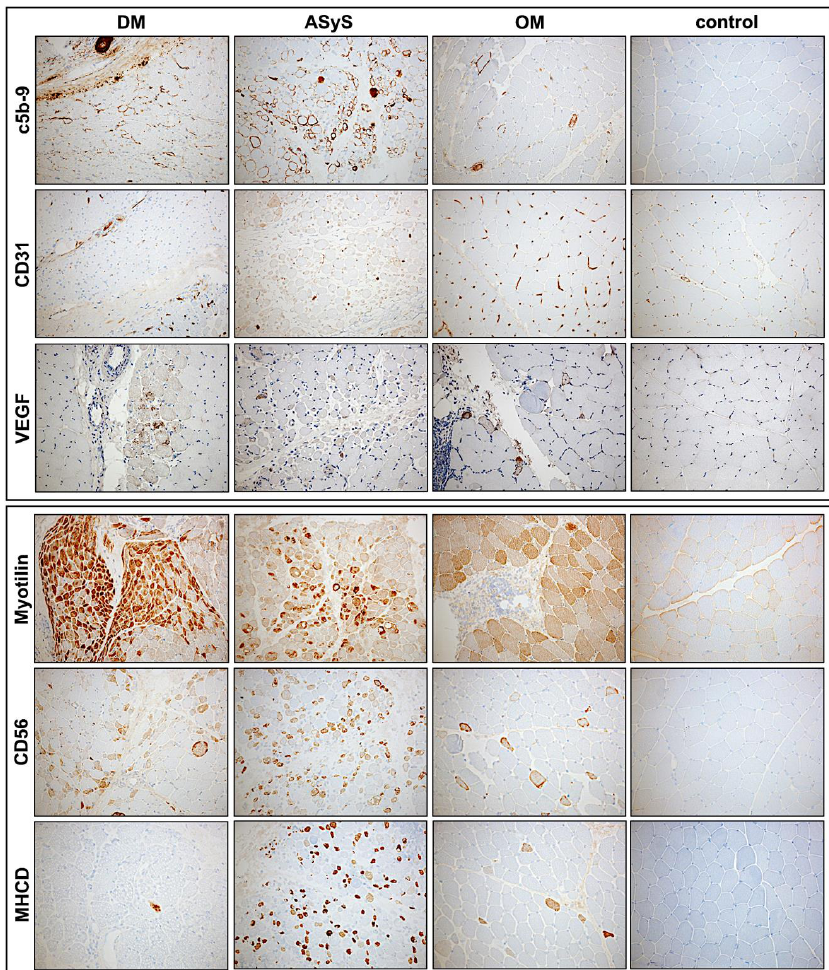
Figure 5. Representative stains of immunohistochemical features of biopsies from patients with DM (P4), anti-Jo1-ASyS (P14), OM (P3) and control. In DM, complement deposits (C5b-9) on endomysial capillaries are strong at the perifascicular region but can also be present in anti-Jo1-ASyS. Strong complement deposits on myofibers are present in anti-Jo1-ASyS in a perifascicular pattern. Few complement deposits are present on scattered fibers in OM. CD31 + endomysial capillaries are reduced in DM and anti-Jo1-ASyS. Focal reduction in CD31 + vessels is also present in OM. Upregulation of vascular endothelial growth factor (VEGF) is mainly seen in DM but can also occur in anti-Jo1-ASyS and OM. Myotilin staining indicates a disorganization of sarcomeric structure. Strong perifascicular sarcomeric disruption is present in DM and less strong in anti-Jo1-ASyS. With antibodies against CD56 and MHCD, a strong regenerative capacity is seen in anti-Jo1-ASyS (magnification 20 × ). (DM = dermatomyositis; ASyS = antisynthetase syndrome; OM = overlap